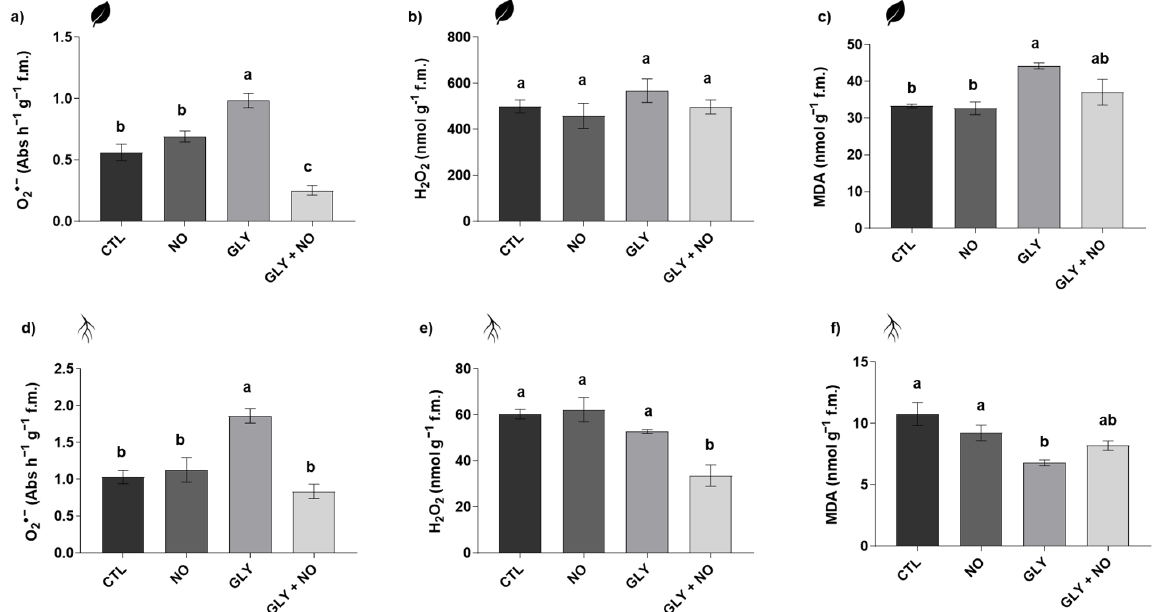
Figure 2. Redox status of Solanum lycopersicum L. cv. Micro-Tom grown for 28 days in an artificial soil contaminated by GLY (10 mg kg − 1 ) and/or foliar sprayed with SNP (200 µ M): ( a , d ) superoxide anion (O 2 •− ) content; ( b , e ) hydrogen peroxide (H 2 O 2 ) content; ( c , f ) malondialdehyde (MDA) levels. CTL—control plants, grown in the absence of GLY and foliar sprayed with dH 2 O once a week (black); NO—plants grown in the absence of GLY and foliar sprayed with SNP once a week (dark grey); GLY—plants grown in the presence of GLY (grey); GLY + NO—plants grown in the presence of GLY and weekly sprayed with SNP (light grey). Results are presented as mean ± standard deviation (SD) and result from the evaluation of at least three experimental replicates (n ≥ 3). Different letters above bars indicate significant differences between groups (CTL, NO, GLY and GLY + NO) at p ≤ 0.05, according to the one-way ANOVA followed by Tukey’s post hoc test.